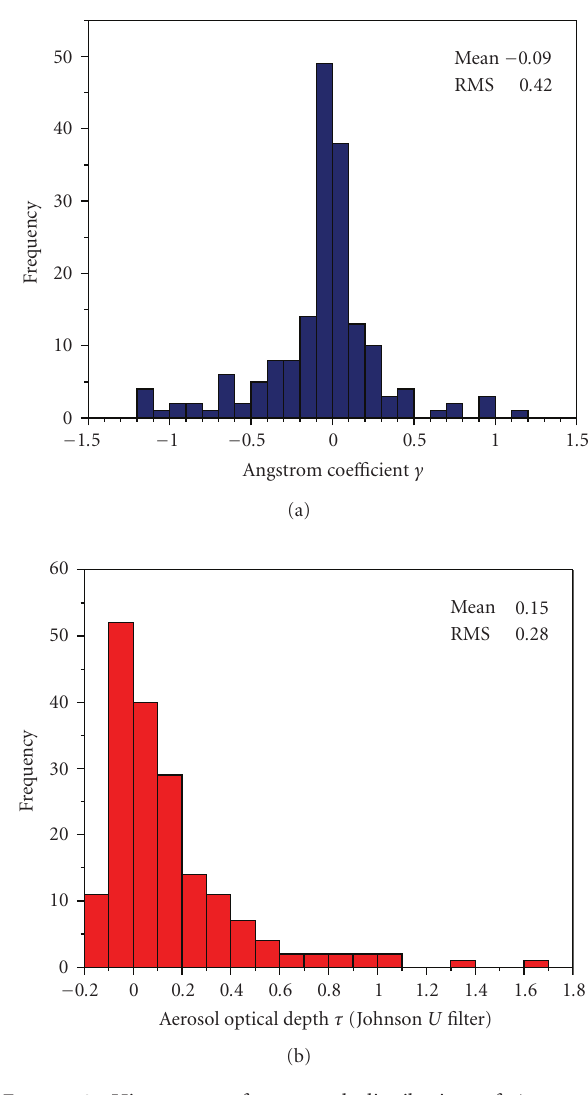
Figure 2: Histograms of measured distribution of Angstrom coe ffi cient γ (a) and of integral aerosol optical depth τ (b) for all data obtained from June 2006 until December 2008. Quality cuts from wide-field camera and photometer were applied as described in the